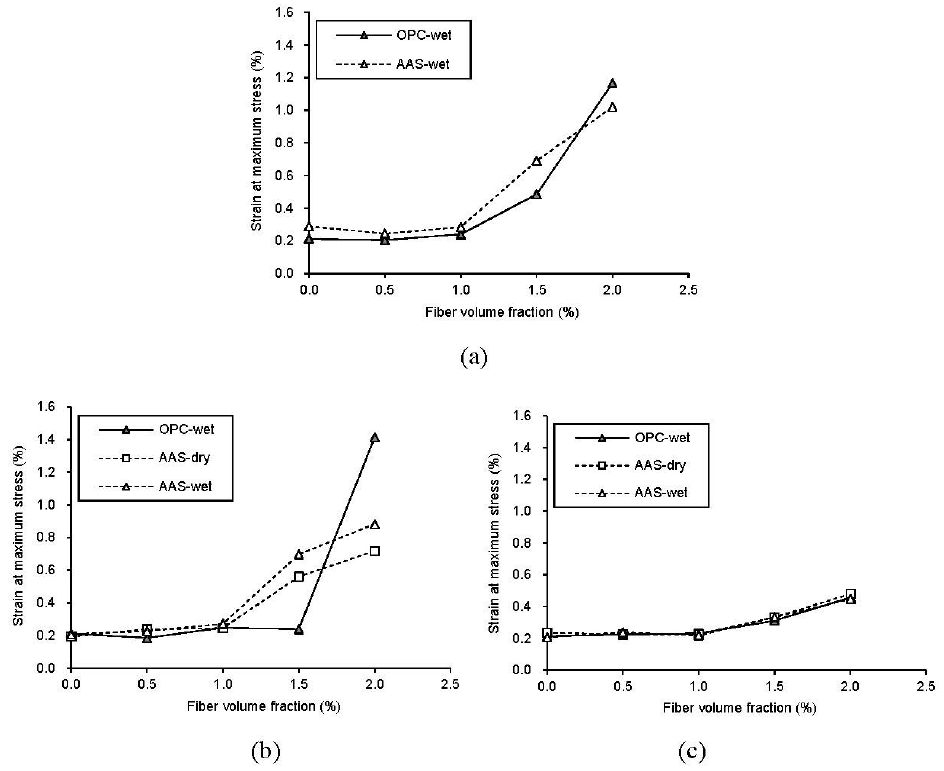
Figure 4. Variation of compressive strain at maximum stress with age. ( a ) 3 days; ( b ) 7 days; ( c ) 28 days. Table 4. Compressive test results.